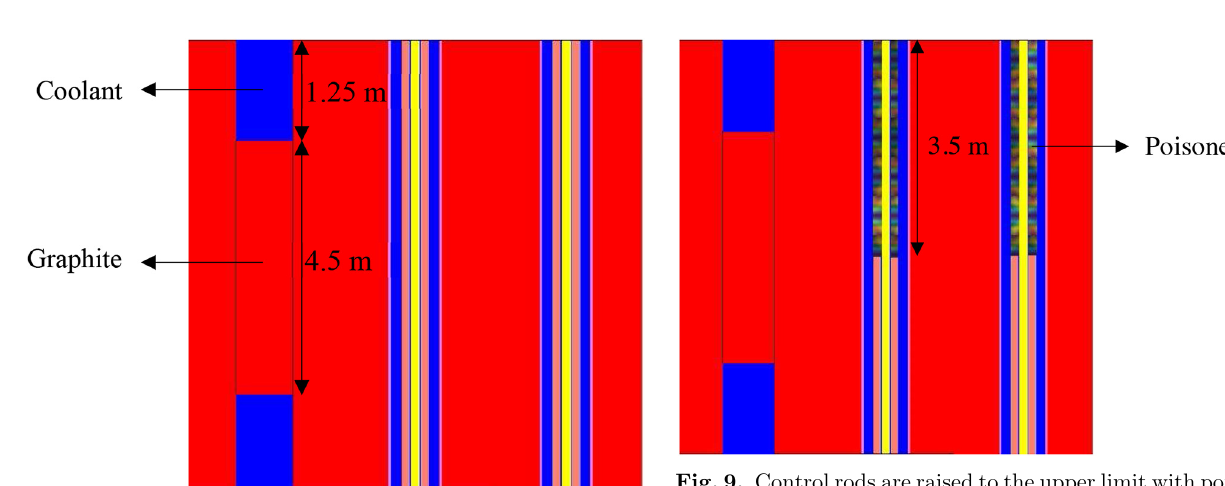
Fig. 9. Control rods are raised to the upper limit with poisoning.